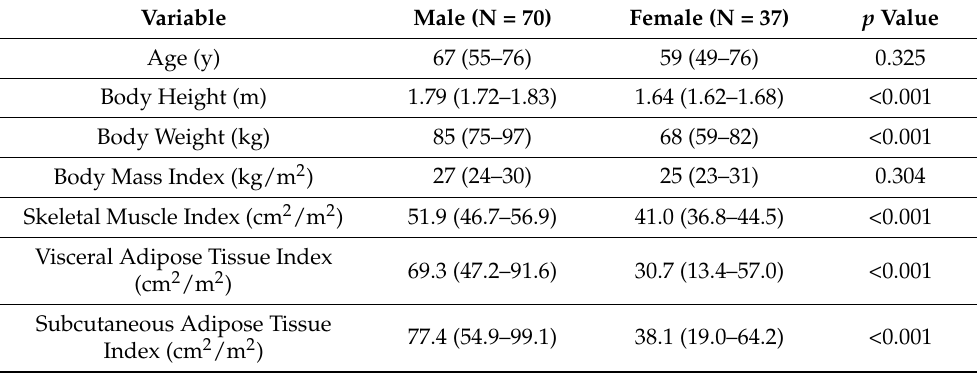
Table 1. Baseline anthropometric characteristics of the study population. Values are provided as median with interquartile range. Mann–Whitney U test was used to compare values between male and female